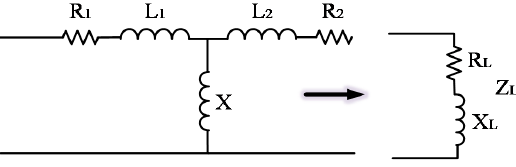
Figure 12. Equivalent circuit of WM and REF.